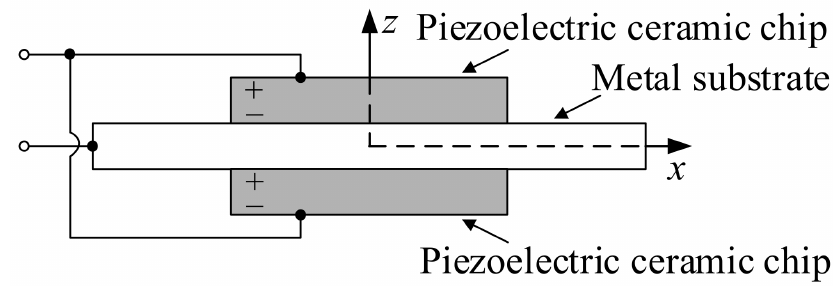
Figure 5. Structural diagram of the transmitting piezoelectric